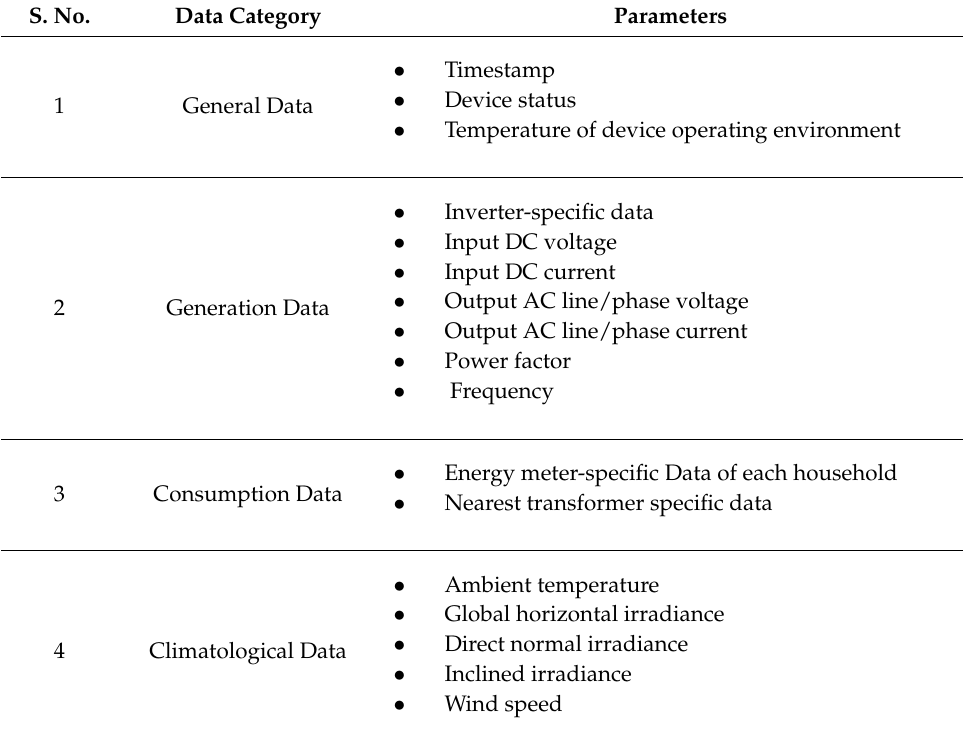
Table 1. Monitoring